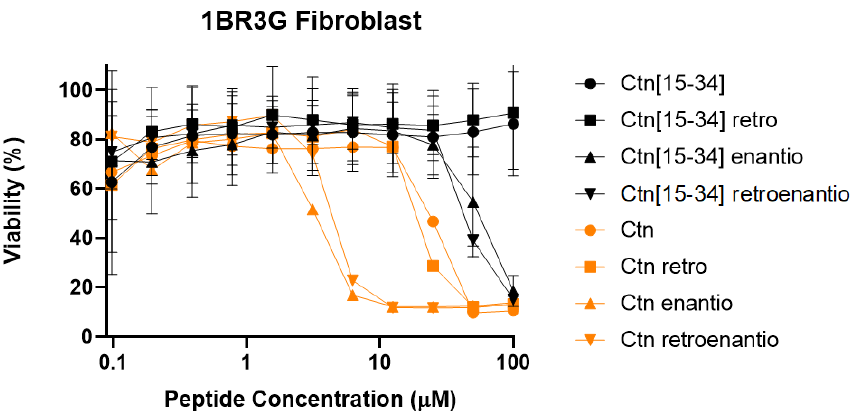
Figure 3. Toxicity of Ctn and Ctn[15-34] topoisomers to eukaryotic cells.